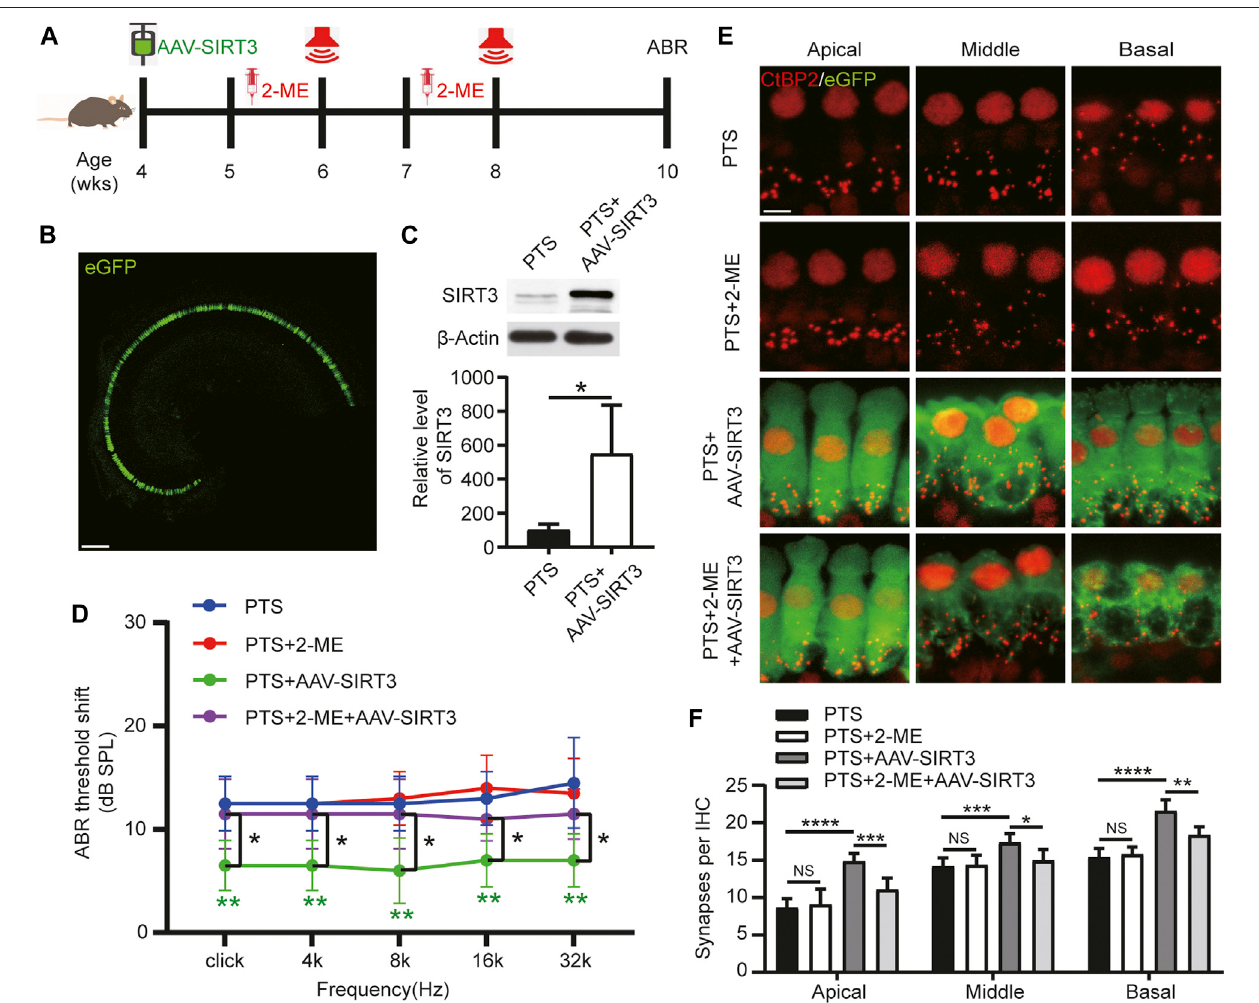
FIGURE6| EffectofAAV-SIRT3andSOD2inhibitorsonthehaircellsofmiceinthePTSgroup. (A) ScheduleofAAV-SIRT3andSOD2inhibitor2-MEadministration toC57BL/6 Jmice. (B) Representativeconfocalimagesofthecochlearapicalturnviatheposteriorsemicircularcanalafterinjecting2 μ LofAAV-SIRT3. (C) WBshowing changes in SIRT3 expression after AAV-SIRT3 injection. (n (cid:1) 4 per group). (D) ABR showing the effects of AAV-SIRT3 and 2-ME on hearing thresholds in PTS mice. (E) Immunohistochemical staining showing the effects of AAV-SIRT3 and 2-ME on the number of presynaptic structures (CtBP2, red) in mice after NE. (F) Quanti fi cation of CtBP2 fl uorescent spots. ( n (cid:1) 10 per group). AAV, adeno-associated virus; PTS, permanent threshold shift; 2-ME, 2-methoxyestradiol; ABR, auditory brainstem response; NE, noise exposure. NS, not signi fi cant; * p < 0.05; ** p < 0.01; *** p < 0.001; **** p < 0.0001. Scale bars: B, 100 μ m; E, 5 μ m.